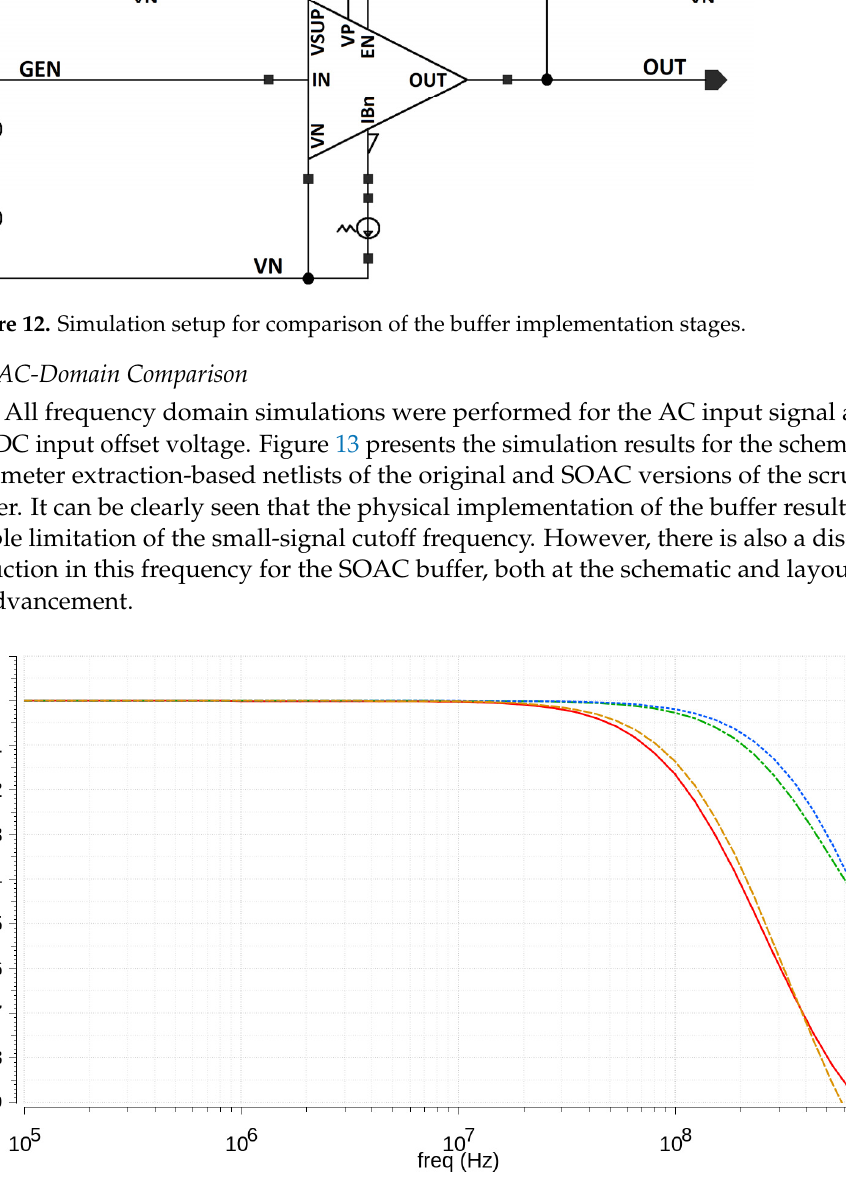
Figure 13. Frequency-domain comparison of the buffer implementation stages: the original buffer— blue dotted line; the SOAC buffer-green dashed-dotted line; the laid-out original buffer—orange dashed line; the laid-out SOAC buffer-red solid line.